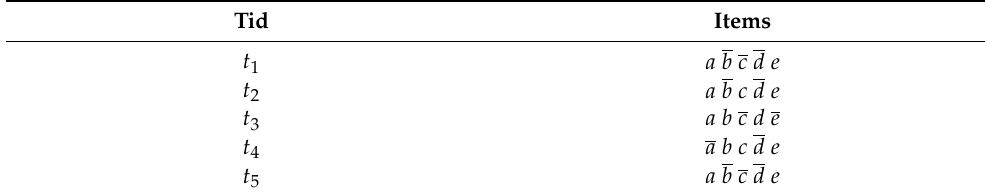
Table 2. A generalized transaction database D . Tid